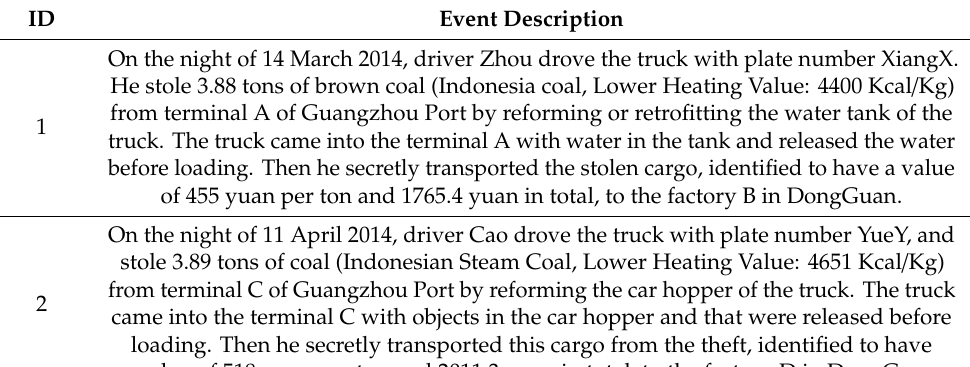
Table 1. Examples of fraud delivery records from sampling inspection.